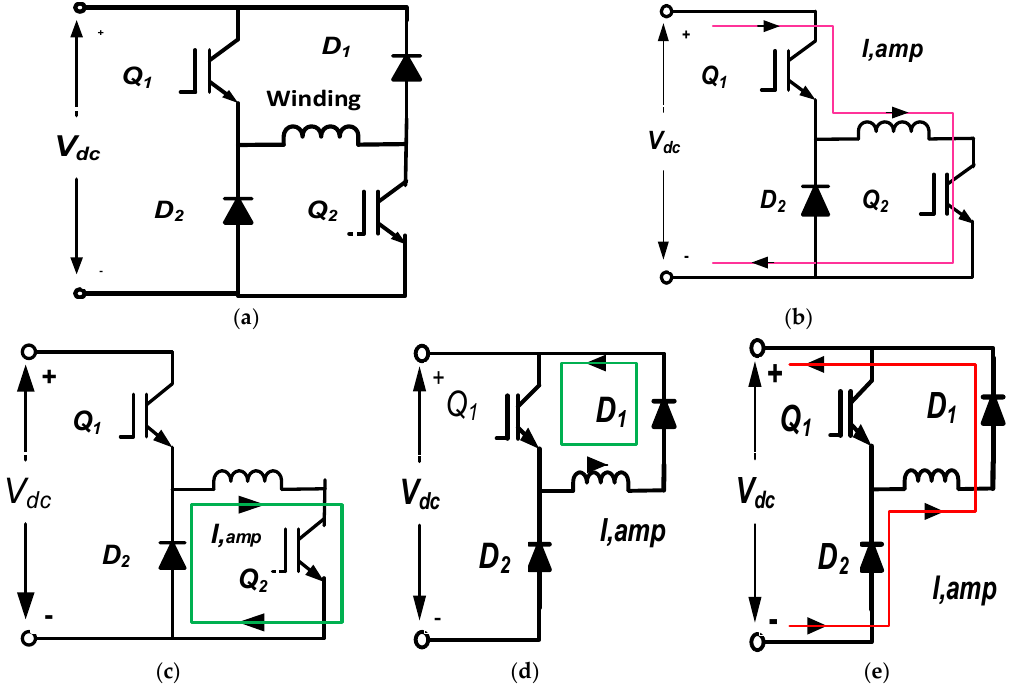
Figure 7. Asymmetric converter switching modes: ( a ) ideal mode; ( b ) Mode 1 ( Q 1 : On; Q 2 : On); ( c ) Mode 2 ( Q 1 : Off; Q 2 : On); ( d ) Mode 3 ( Q 1 : On; Q 2 : Off); ( e ) Mode 4 ( Q 1 : Off; Q 2 : Off). (Note: Q 1 and Q 2 are IGBT switches, and D 1 and D 2 are freewheeling diodes).